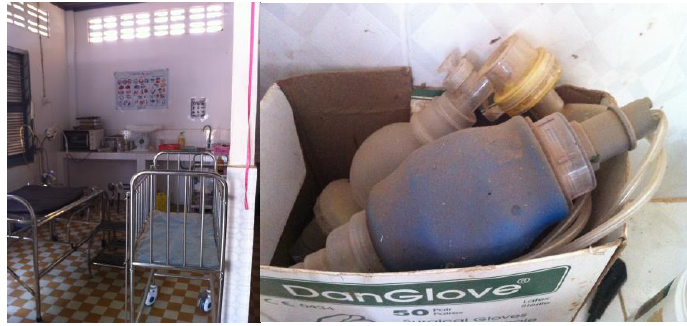
Figure 2. Health facility delivery room and bag valve masks for resuscitation.